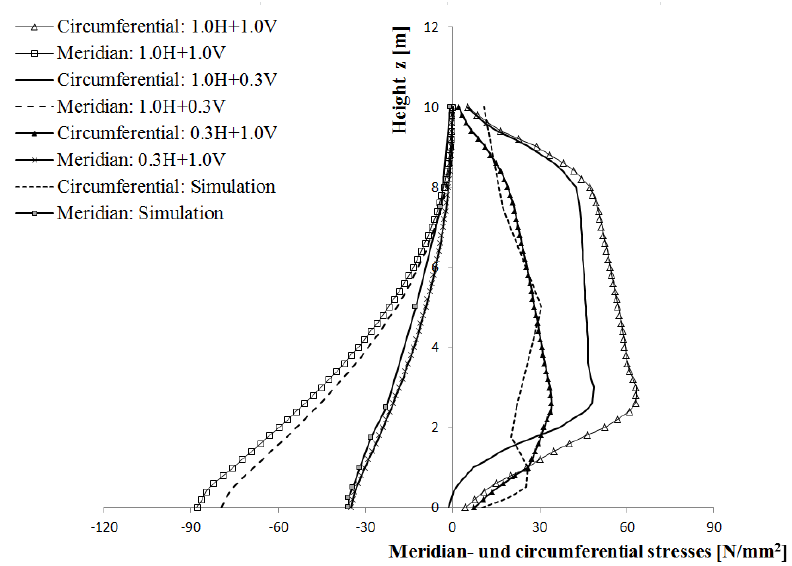
Figure 12. Synthetically generated acceleration time histories.